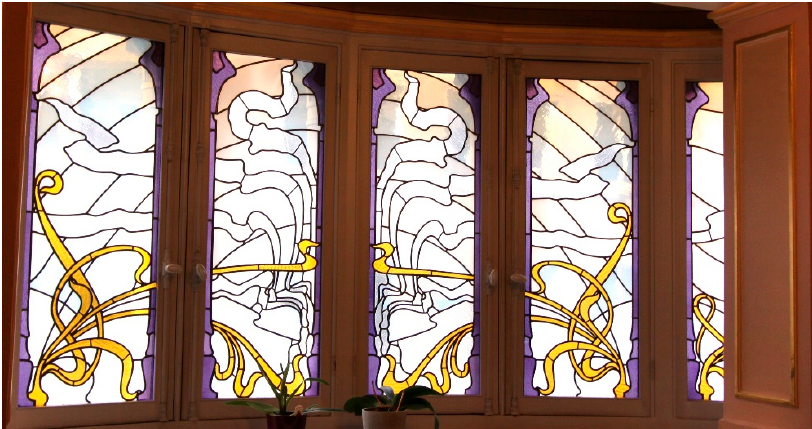
Figure 8. The natural colors and biomorphic motives of the stained-glass window on the first floor in the Tassel House.